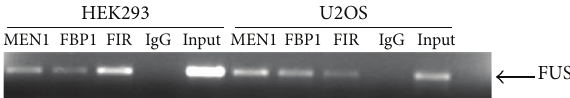
Figure 2: Menin binds to FUSE. DNA was immunoprecipitated from HEK293 and U2OS cells using, menin, FBP1, FIR, or normal rabbit IgG antibodies. The FUSE region was amplified and run on an agarose gel.